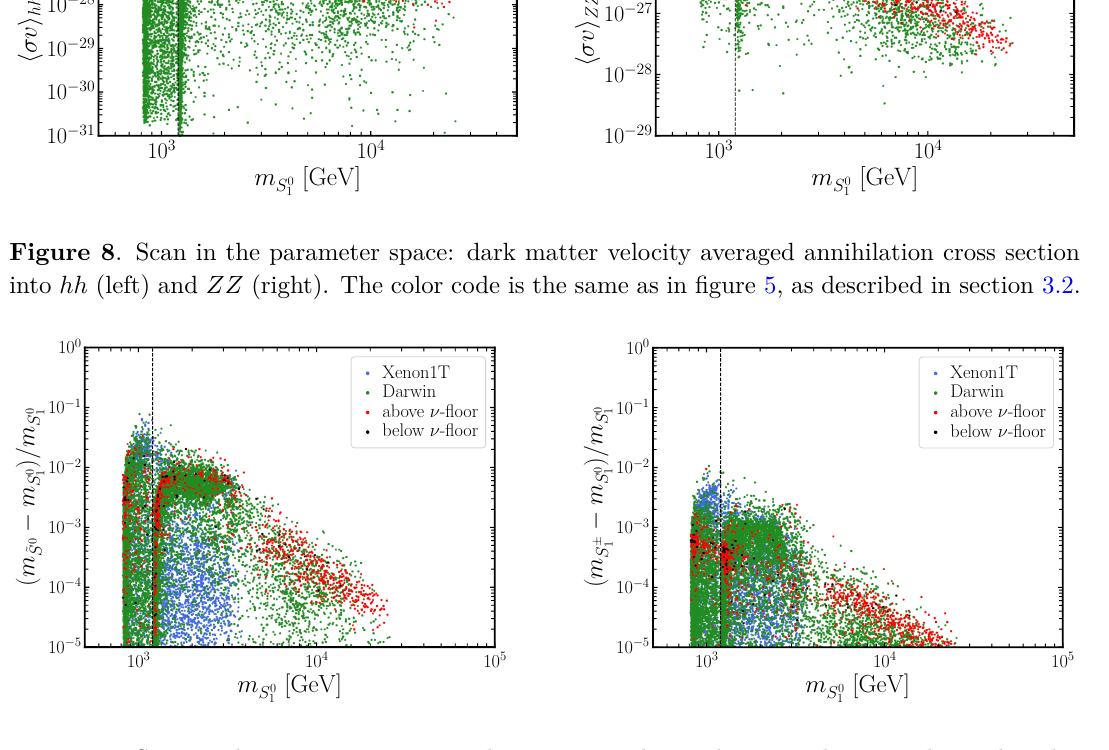
Figure 9 . Scan in the parameter space: relative mass splitting between the neutral pseudoscalar (left), the lightest charged scalar (right) and the dark matter candidate. The color code is the same as in figure 5, as described in section